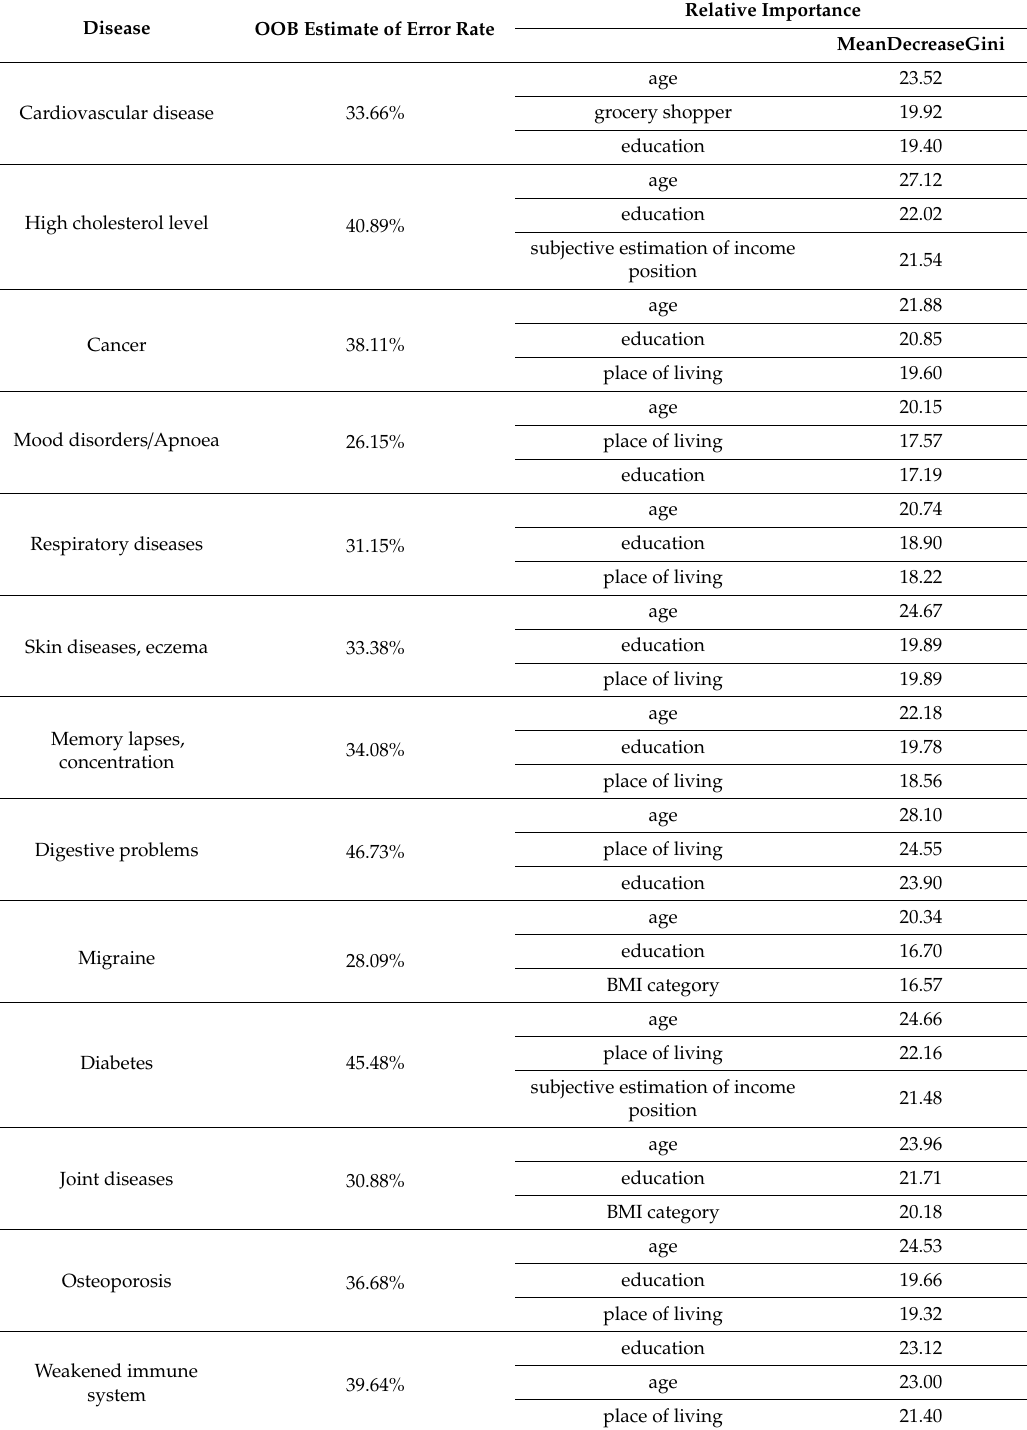
Table 5. Results obtained with the help of random